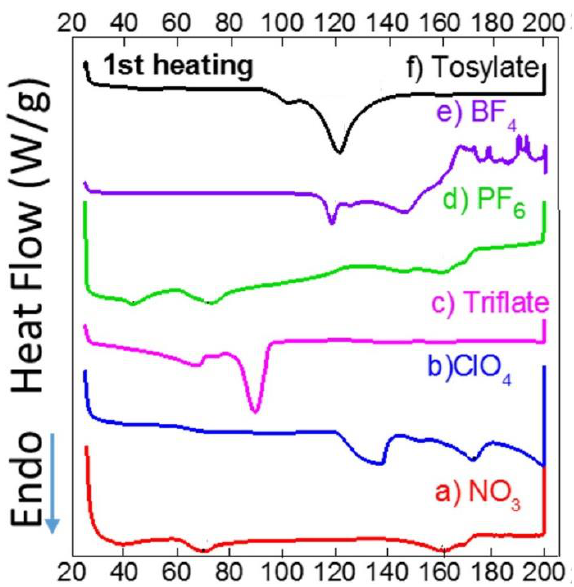
Figure 10. Thermographs for crystals 1 – 6 when heated from room temperature to 200 °C.